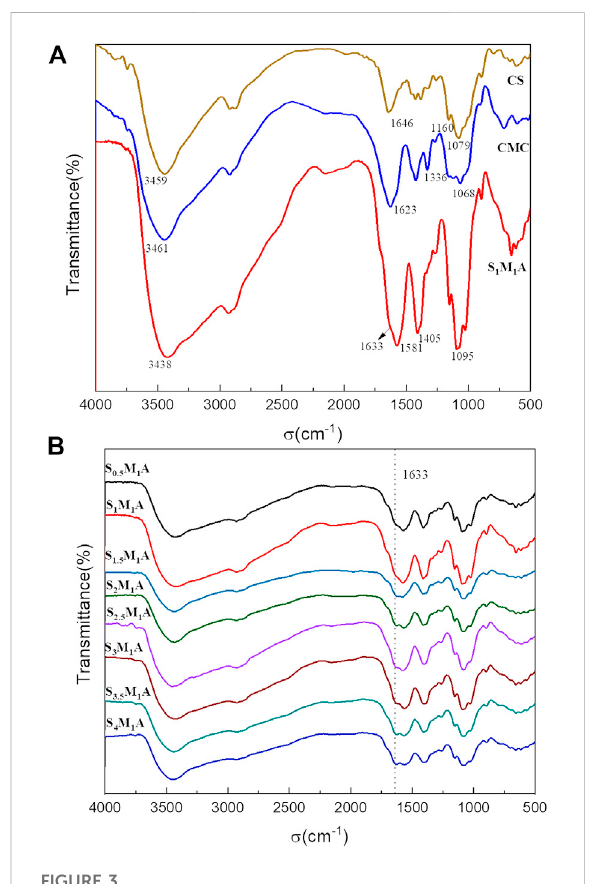
FIGURE 3 FT-IR spectra of (A) S 1 M 1 A, CMC, CS; and (B) . aerogels prepared at different CS/CMC